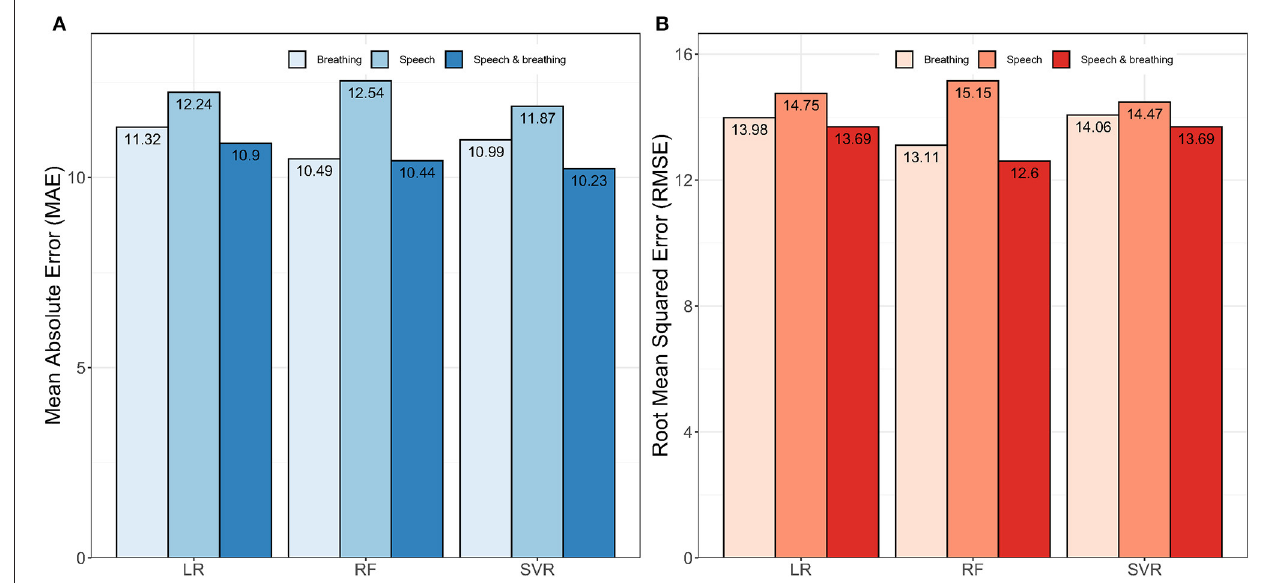
FIGURE 1 | Impact of speech and breathing features individually and combined on model development. (A) Shows the performances of the models in terms of mean absolute error (MAE) and (B) presents the performances of the models in terms of root mean squared error (RMSE). Here, LR, Linear Regression; RF, Random Forest; SVR, Support Vector